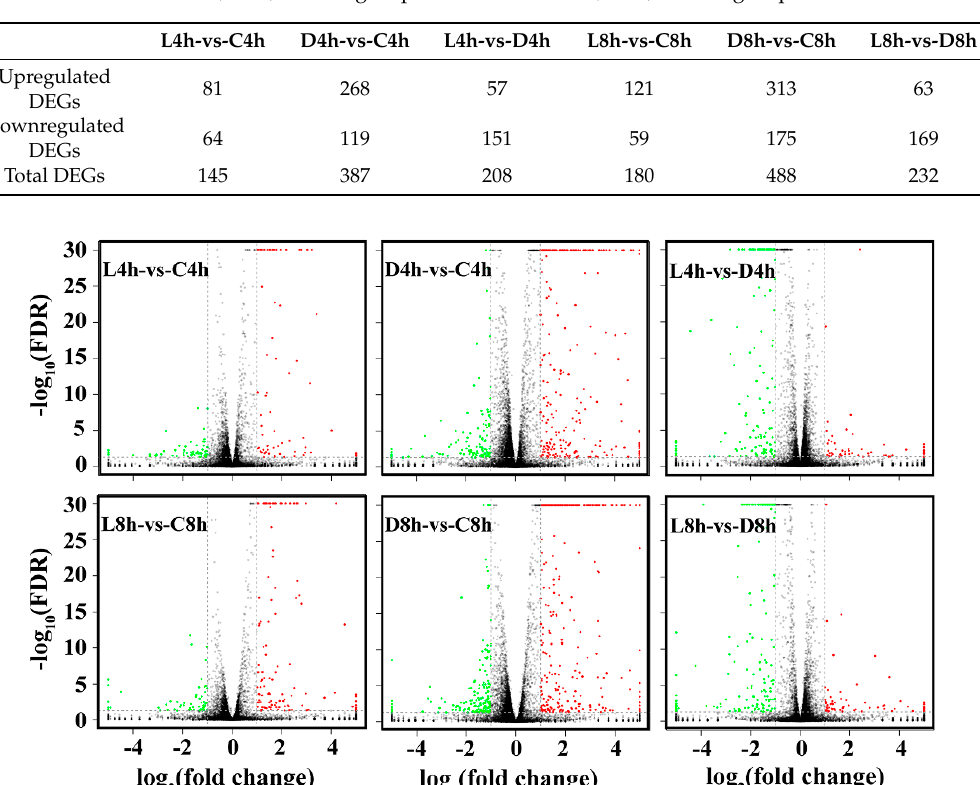
treatment for 4 h; L8h, live E. tarda treatment for 8 h; D4h, dead E. tarda treatment for 4 h; D8h, dead E. tarda treatment for 8 h; C4h, control group at 4 h of treatment; C8h, control group at 8 h of treatment.